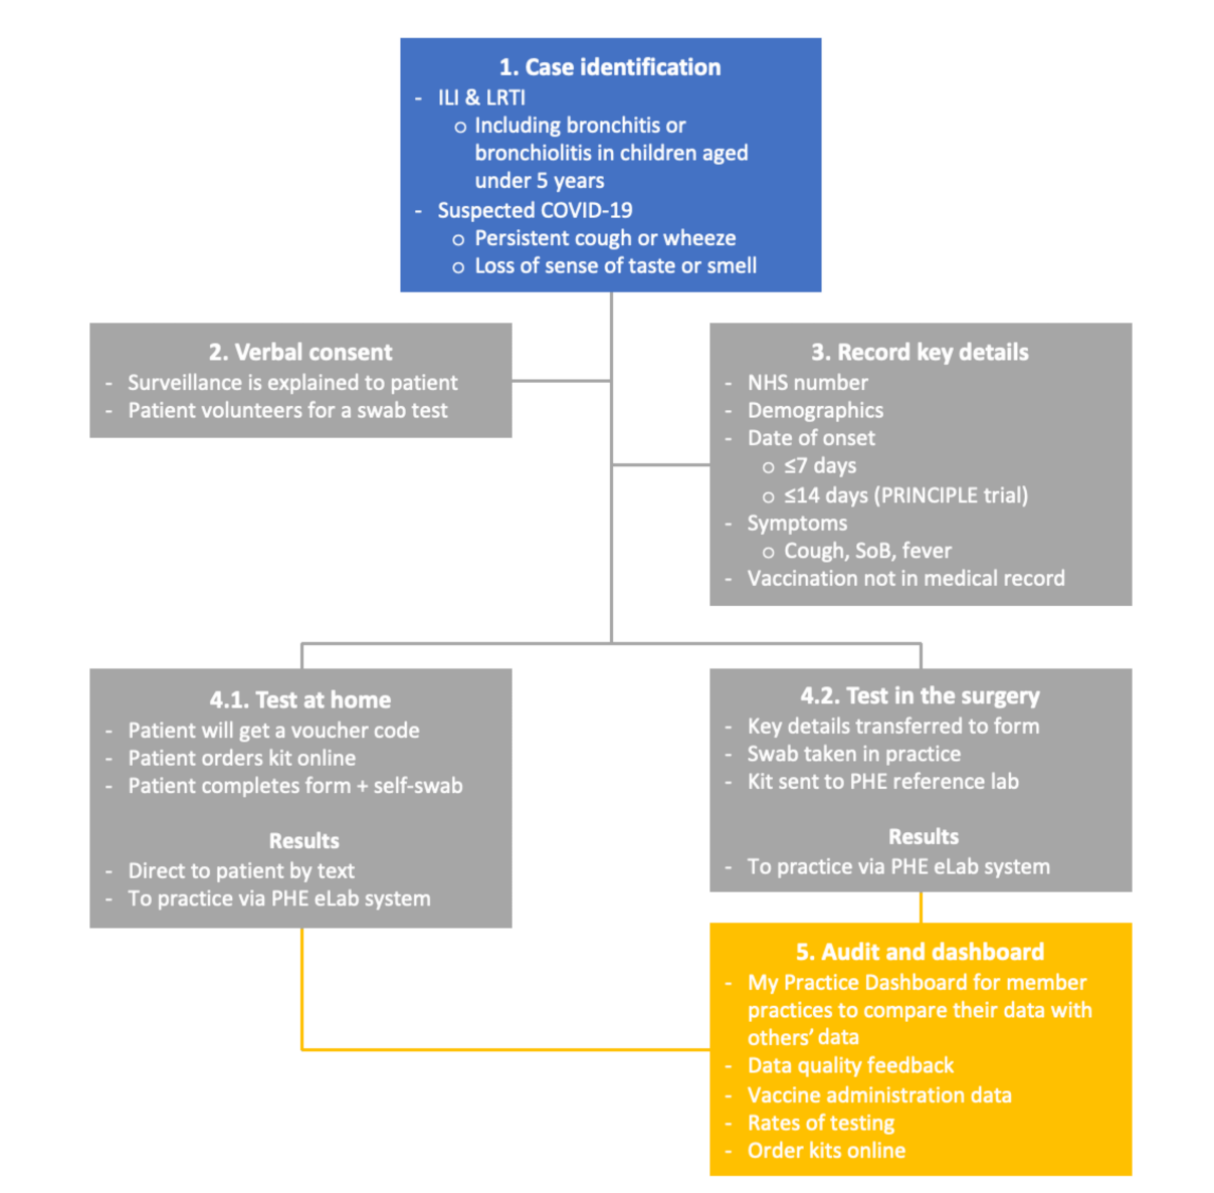
Figure 3. Flowchart for case identification and sampling for the 2020-2021 season surveillance. The National Health Service (NHS) number is a vital unique identifier for all forms across virology and serology, including for patients requesting a test kit at home. ILI: influenza-like illness; LRTI: lower respiratory tract infection; PHE: Public Health England; PRINCIPLE: Platform Randomised trial of INterventions against COVID-19 In older peoPLE; SoB: shortness of